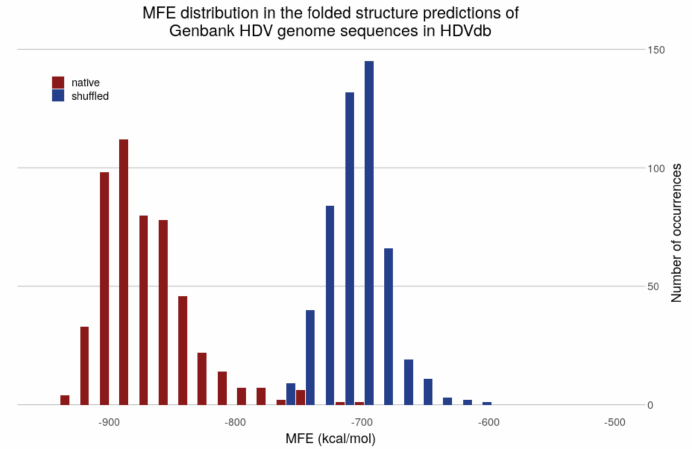
Figure 5. The MFE distribution of all structures in our dataset comparing native and shuffled sequences. Shuffled sequences with dinucleotide shuffling were obtained using shuffleseq from EMBOSS. Reported p -value (see text) is less than